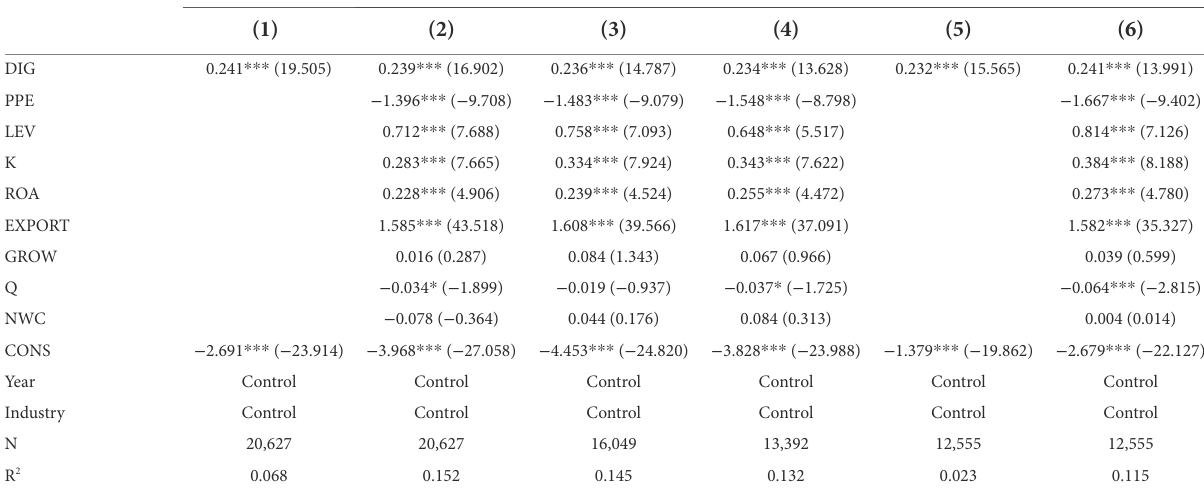
TABLE 4 OFDI_1 basic regression